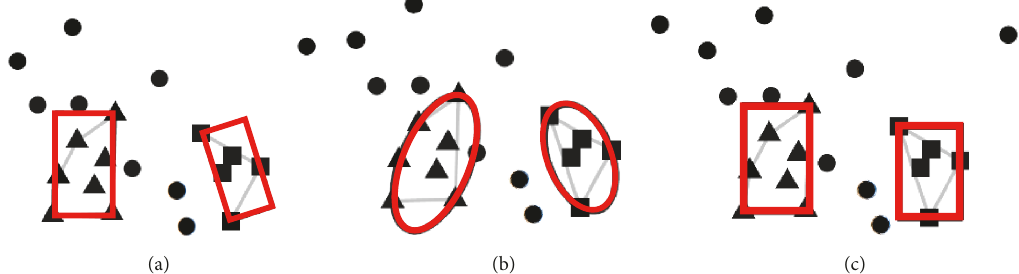
Figure 3: Modelling the boarding clusters: (a) minimal bounding box (MBB); (b) minimal bounding ellipse (MBE); (c) minimal bounding horizontal box (MBHB). The grey shape represents the convex hull, i.e., the smallest convex polygon containing the points. The red shape represents the selected model ((a) MBB; (b) MBE; (c) MBHB). Alighting passengers are represented by bullet points; boarding passengers by triangles (left side of the door) and squares (right side of door).